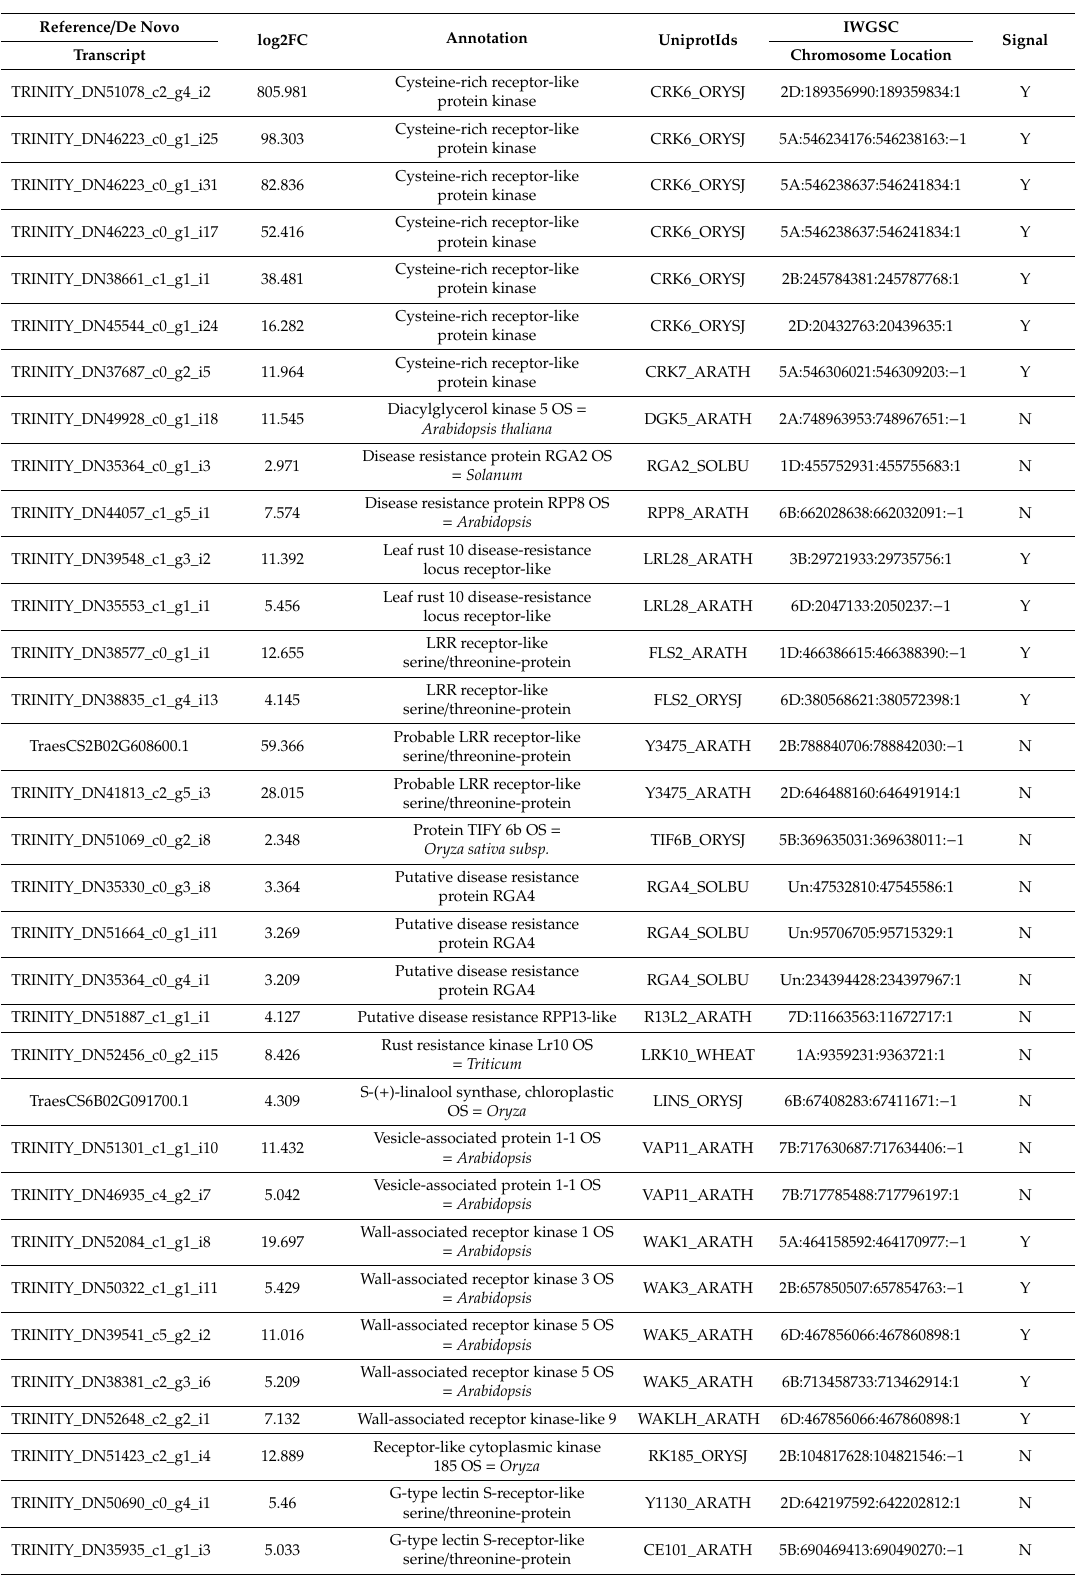
Table 3. List of upregulated di ff erentially expressed genes ( p -value < 0.05) in de novo and reference assemblies that can be considered as potential candidate genes involved in resistance. The table is sorted according to p -values. FC: fold change. IWGSC: International Wheat Genome Sequencing Consortium Reference / De Novo